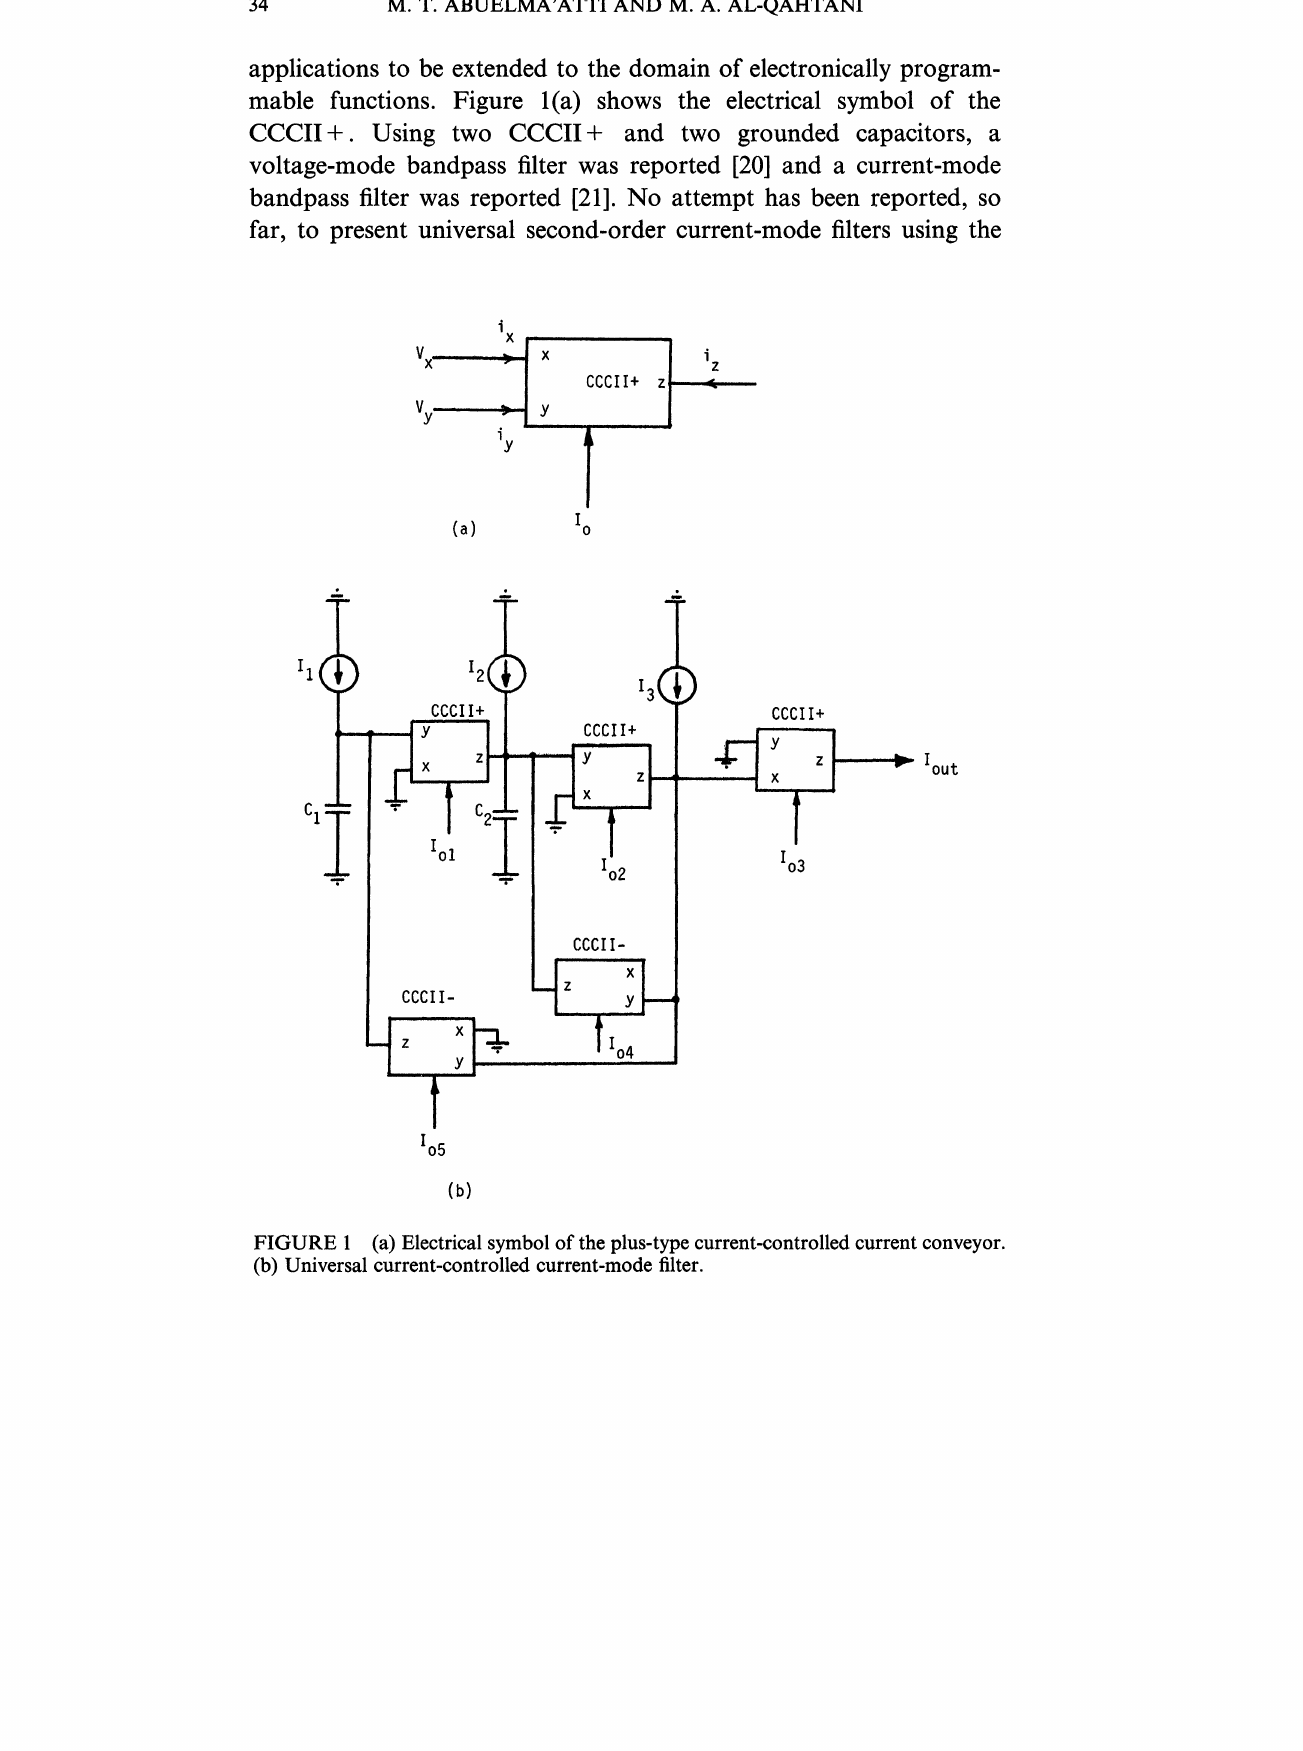
FIGURE (a) Electrical symbol of the plus-type current-controlled current conveyor. (b) Universal current-controlled current-mode